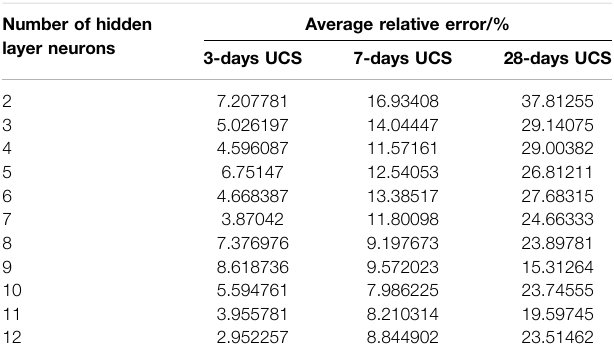
TABLE 3 | Average relative error of number and intensity prediction of neurons in different hidden layers. Number of hidden layer neurons